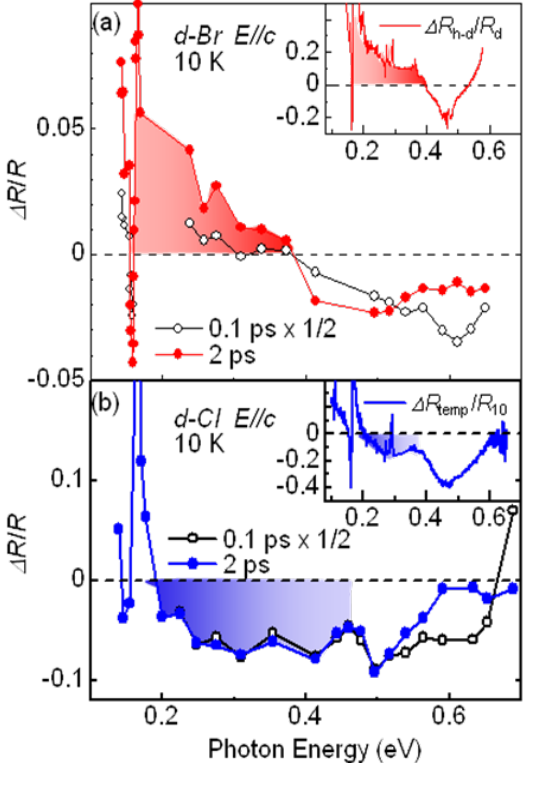
/ R ; blue curve) of d -r temp 10